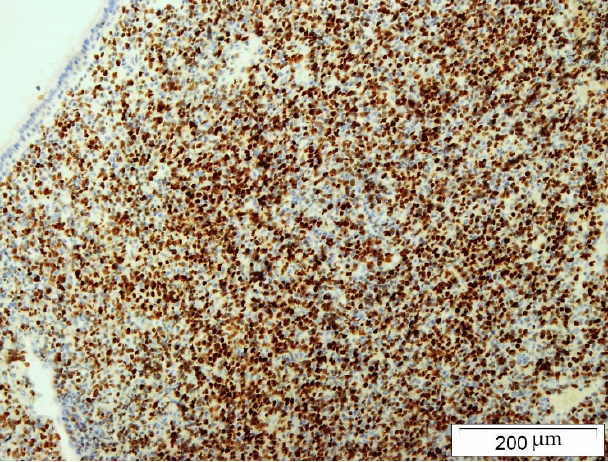
Figure 6. Tumor biopsy: bcl ‐ 6 staining.